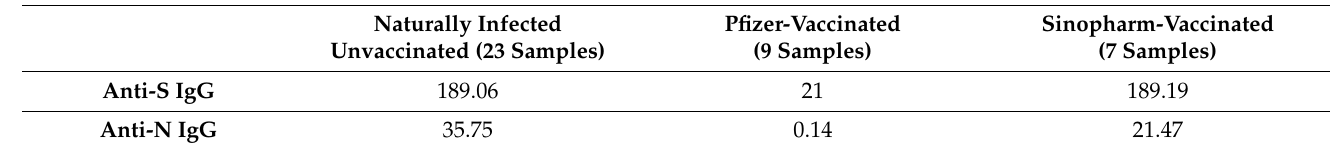
Table 3. Comparison among antibody titer median of all three groups for anti-N and anti-S IgG, which are anti-N IgM